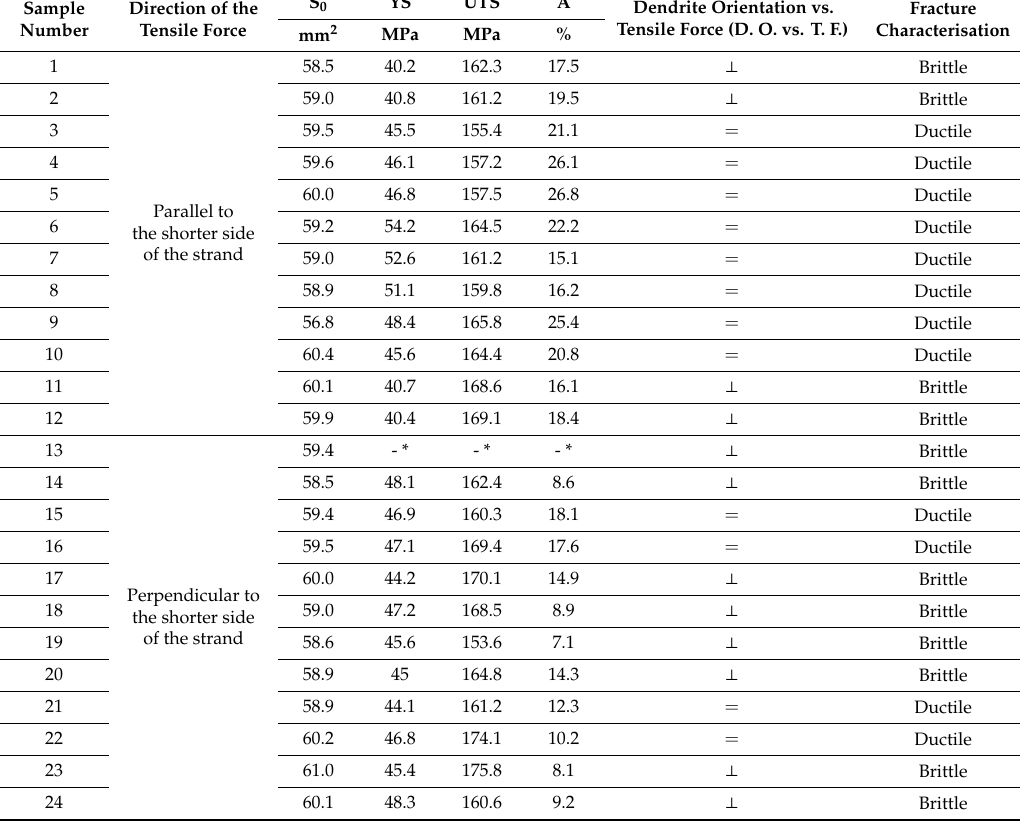
Table 2. Mechanical properties of the copper strand samples subjected to uniaxial tensile